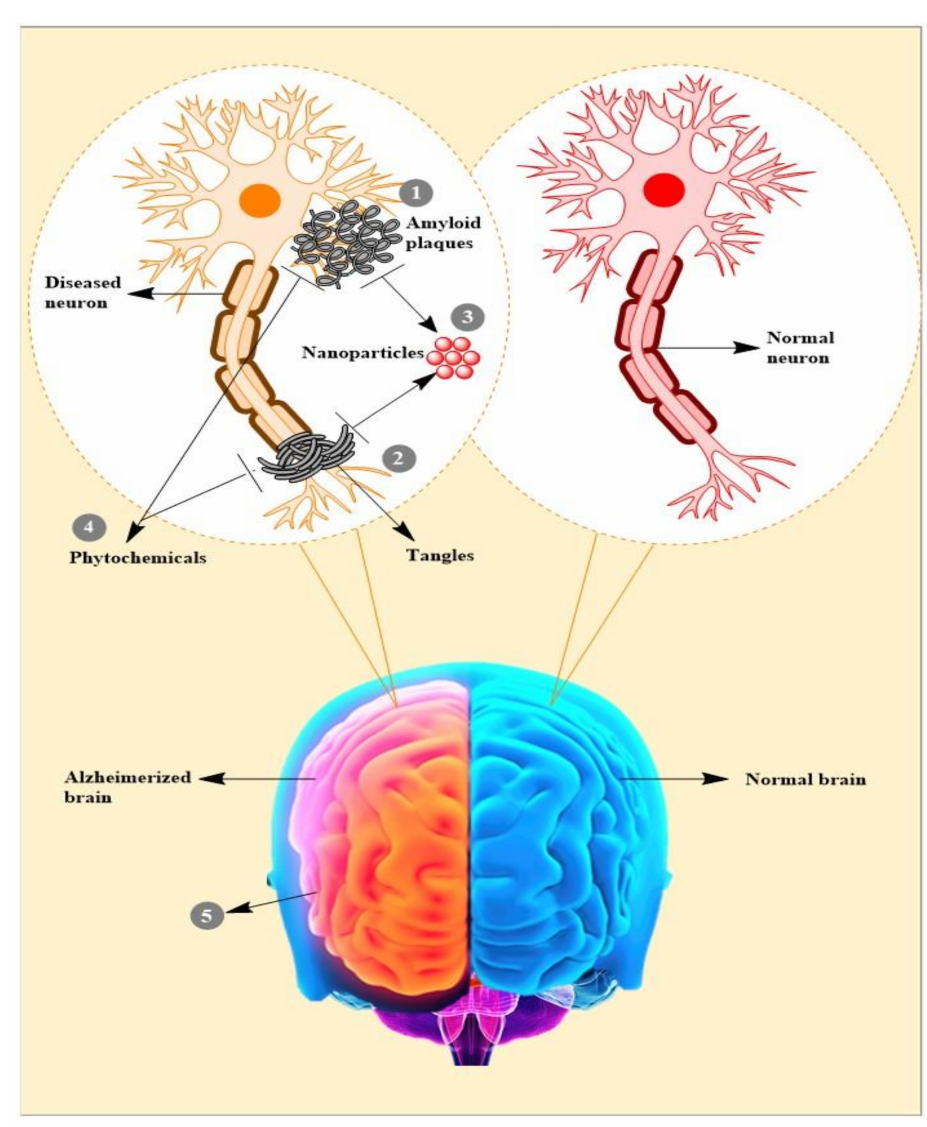
Figure 1. Therapeutic interventions of phytochemicals and nanoparticles in the treatment. (1) Beta-amyloid fragments cluster together and forms plaques. They appear to have a toxic effect on neurons and disrupt cell-to-cell communication. (2) In Alzheimer’s disease, tau proteins change shape and organize themselves into structures called neurofibrillary tangles. The tangles disrupt the transport system and are toxic to cells. (3) Nanoparticles effectively disintegrate mature fibrils and inhibit formation of the β -amyloid fibrillation. (4) Multiple phytochemicals are considered as potent anti-Alzheimer’s medications due to their inhibitory potential for key neurotransmitters in AD. (5) Problems associated with Alzheimer’s disease: Restlessness, Agitation, Depression, Bowel problems, Wandering, Dry mouth,